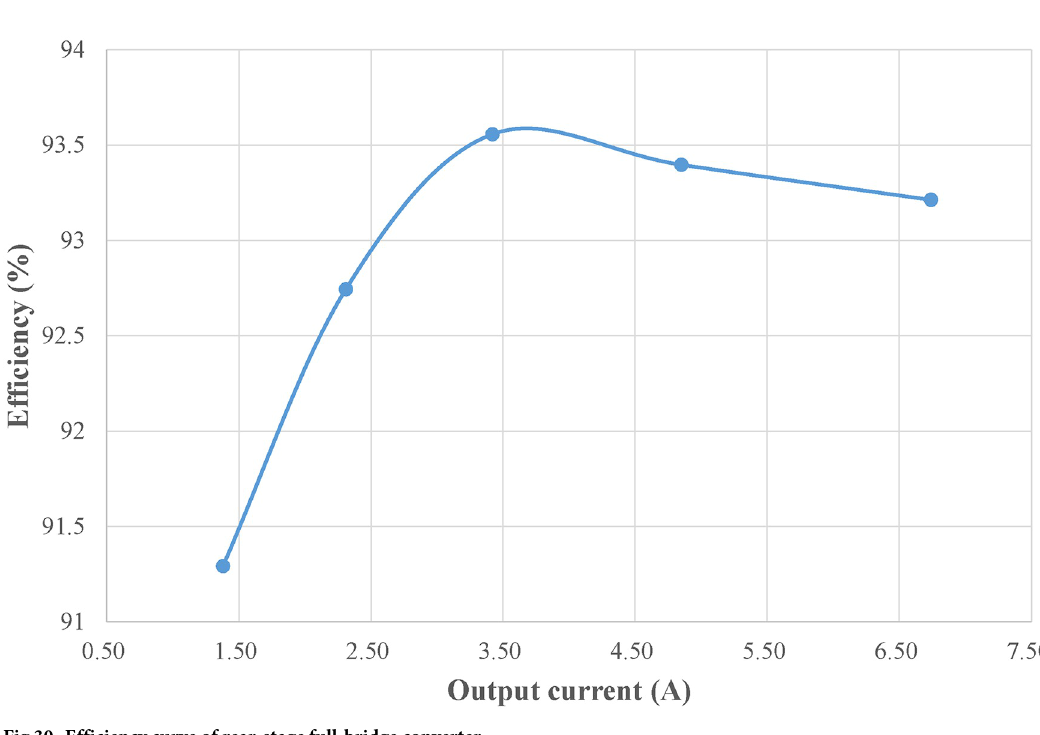
Fig 30. Efficiency curve of rear-stage full-bridge